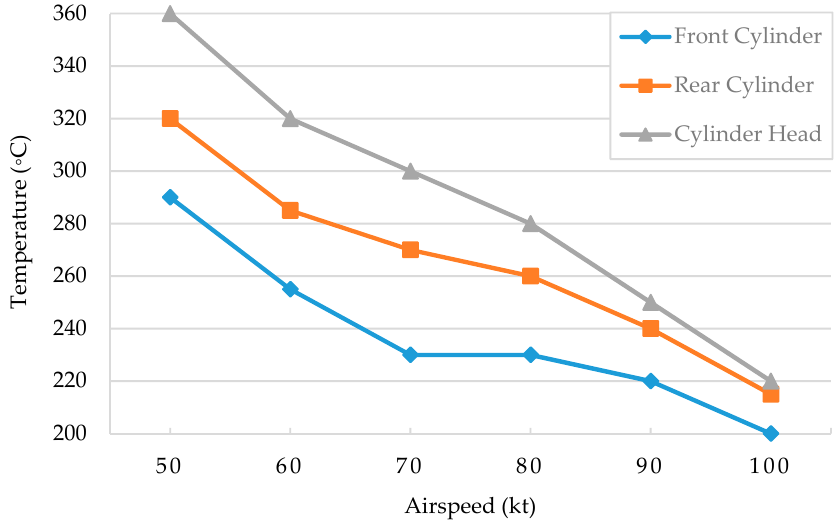
Figure 6. Graph relationships between temperature (°C) and airspeed (kt) at an initial temperature of 240 °C.